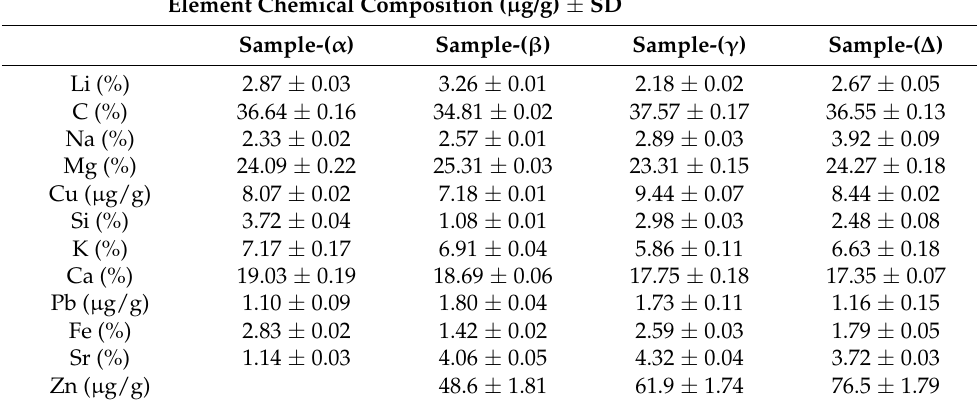
Table 2. Estimated average elemental composition of major (wt.%), minor (wt.%), and traces ( µ g/g) by CF-LIBS along with